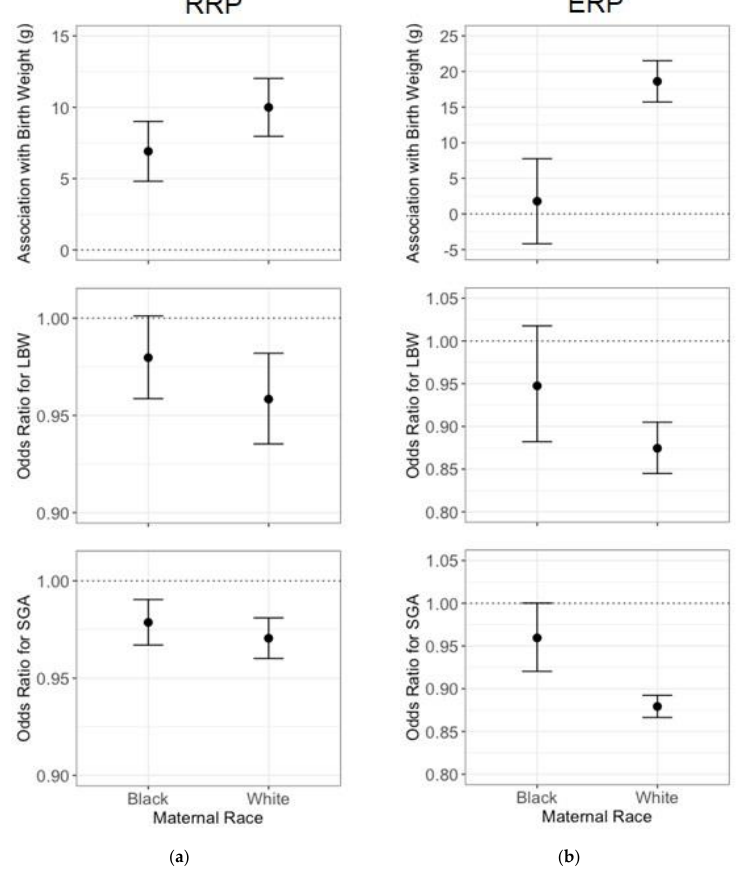
Figure 1. Association between an Interquartile Range (IQR) Difference in Census Tract ( a ) Racial Residential Polarization (RRP; IQR = 0.24) or ( b ) Economic Residential Polarization (ERP; IQR = 0.37) and Continuous Birth Weight, Odds for Low Birth Weight (LBW), and Odds for Small for Gestational Age (SGA) in Massachusetts from 2001 to 2013 ( n = 629,675). Estimated effects and 95% confidence intervals are presented separately for those born to black mothers and those born to white mothers. Model covariates include: particulate matter under 2.5 µm in aerodynamic diameter (PM 2.5 ), clinical gestat ional age, mother’s age, infant sex, year of birth, maternal marital status, Medicaid status, maternal smoking, gestational diabetes, other diabetes, high blood pressure during pregnancy, chronic high blood pressure, parity, mode of delivery, Kessner index for adequacy of prenatal care, and maternal education.